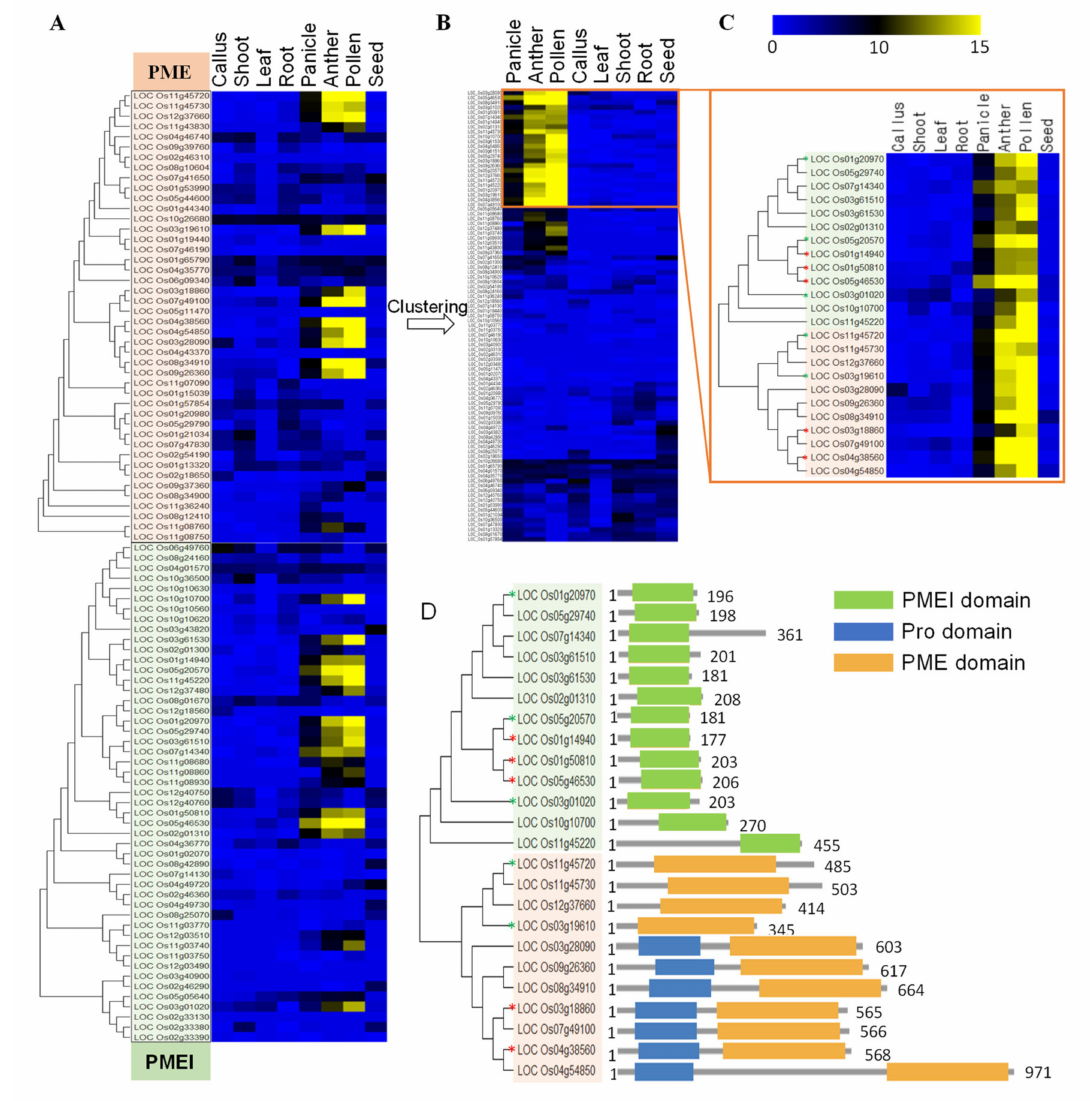
Figure 4. Meta-expression analysis and genome-wide identification of pollen-specific PMEs and PMEIs in rice. ( A ) Phylogenomic analysis and Heat map expression of PME and PMEI encoded in rice genome. ( B ) Clustering analysis by the HCL method / Euclidean distance / average linkage. ( C ) The focused heat map of pollen-preferred rice PME and PMEI genes. ( D ) Domain analysis of pollen-specific PME and PMEI proteins. The color of the cell in heat map represents transcript abundance. Blue colored boxes denote a low level of expression, and yellow colored boxes denote a high level of expression. Whole PME and PMEI genes in rice were analyzed for phylogenetic relationship and